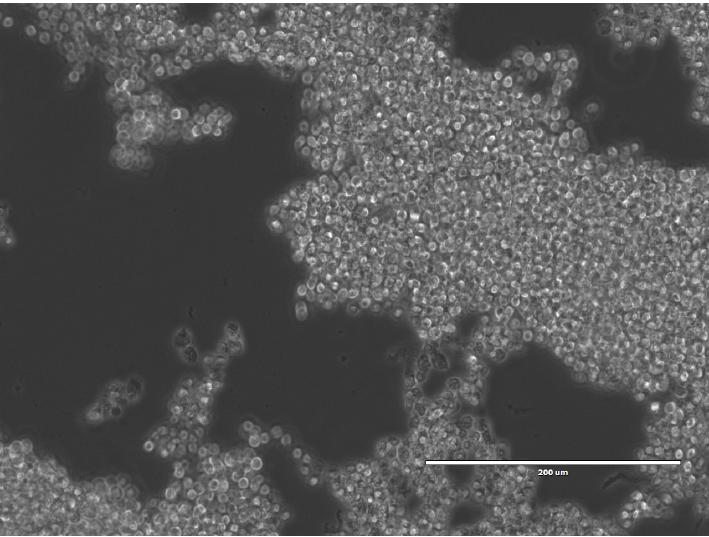
Figure 3. 3D SH-SY5Y cells seeded in a PDMS ring confinement with a diameter of 3 mm on a microscope cover slip with poly (ethylene glycol) diacrylate (PEGDA) on top on day 1. The scale bar indicates 200